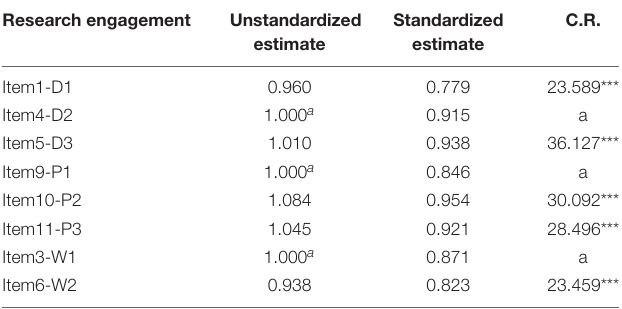
TABLE 6 | CFA regression weights for the three-factor correlated model of research self-efficacy. Research engagement